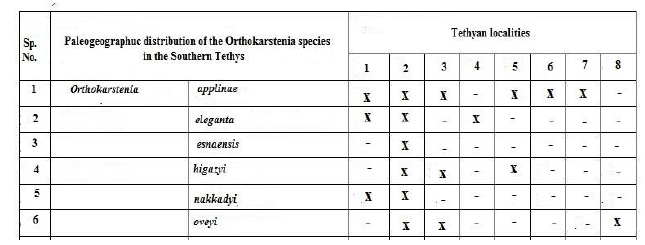
Figure 4: Maastrichtian-Paleocene paleogeographic map of the Northern Tethys (Spain, France, Italy), and Southern Tethys (Niger, Tunisia, Libya, Egypt, Jordan, Iraq, Saudi Arabia, Qatar, UAE, Iran, Pakistan), showing possible migration routes of the members of the two diagnostic benthic genera: Bolivinoides and Orthokarstenia (Morsi et al., 2008).